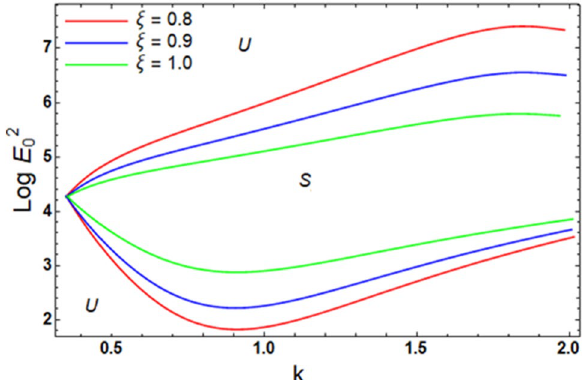
Figure 10. Exhibits the alteration in ξ inequality (62) and (63).